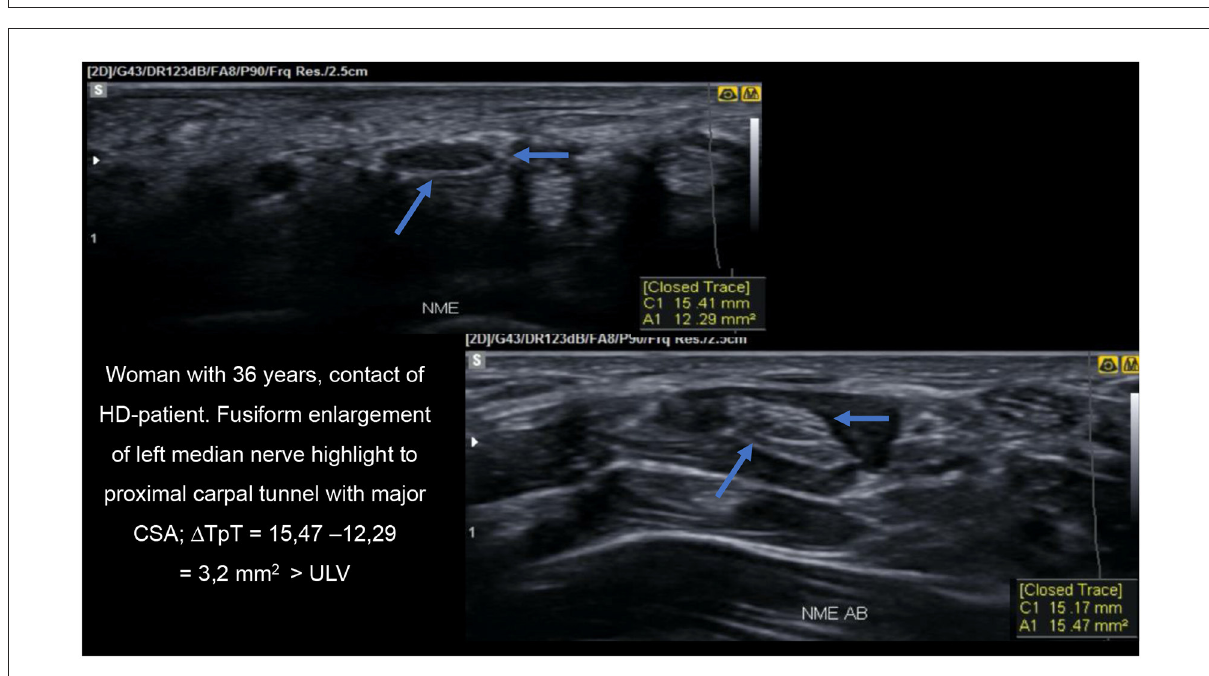
FIGURE9 HRUS image demonstrating thickening of the median nerve proximal to the carpal tunnel on transverse view.